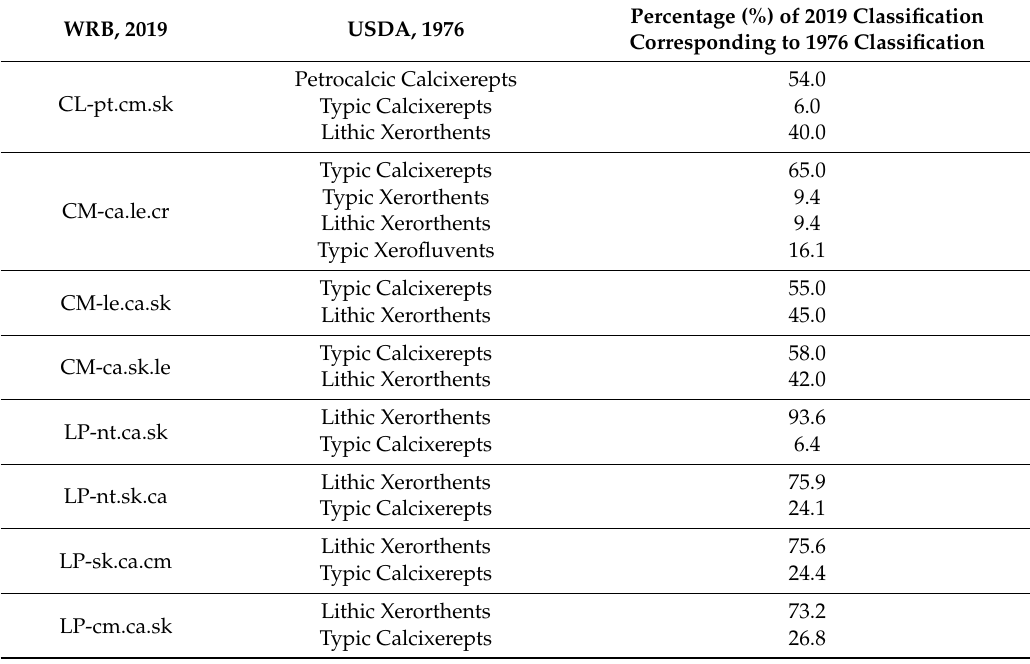
Table 3. Table of di ff erences between the classifications of the two systems on a spatial